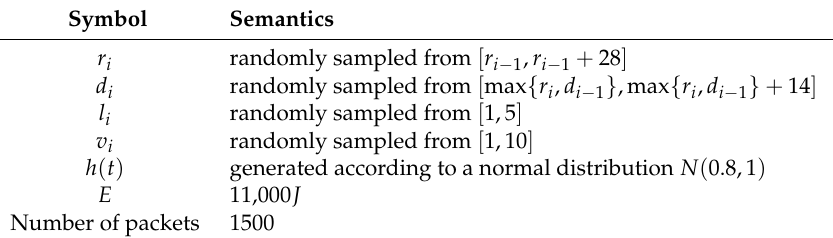
Table 2. Simulation default settings on FIFO tasks.